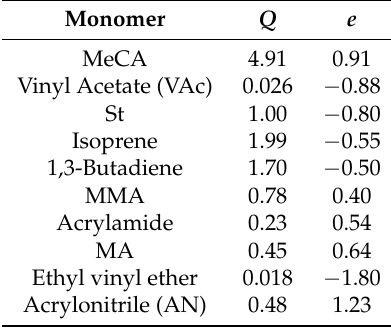
Table 5. Q and e values for methyl 2-cyanoacrylate (MeCN) and common